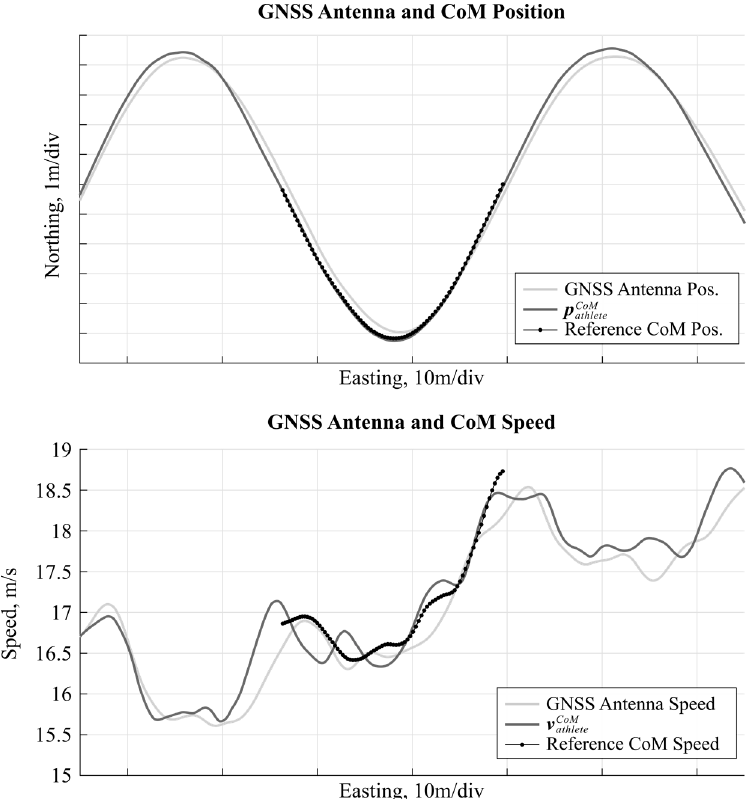
Figure 3. Position and speed curves for three consecutive turns (gates 6–8, Figure 1A) of a typical run. The central turn (gate 7) has been covered by the reference system. The athlete skied from left to right. ( Top ) GNSS antenna position (light grey), p CoM (dark grey), and reference CoM position (dotted black) during the same turn. ( Bottom ) GNSS antenna speed (light grey), v CoM (dark grey), and reference CoM speed (dotted black) during the same turn. Both figures are aligned such that their Easting axes are identical.